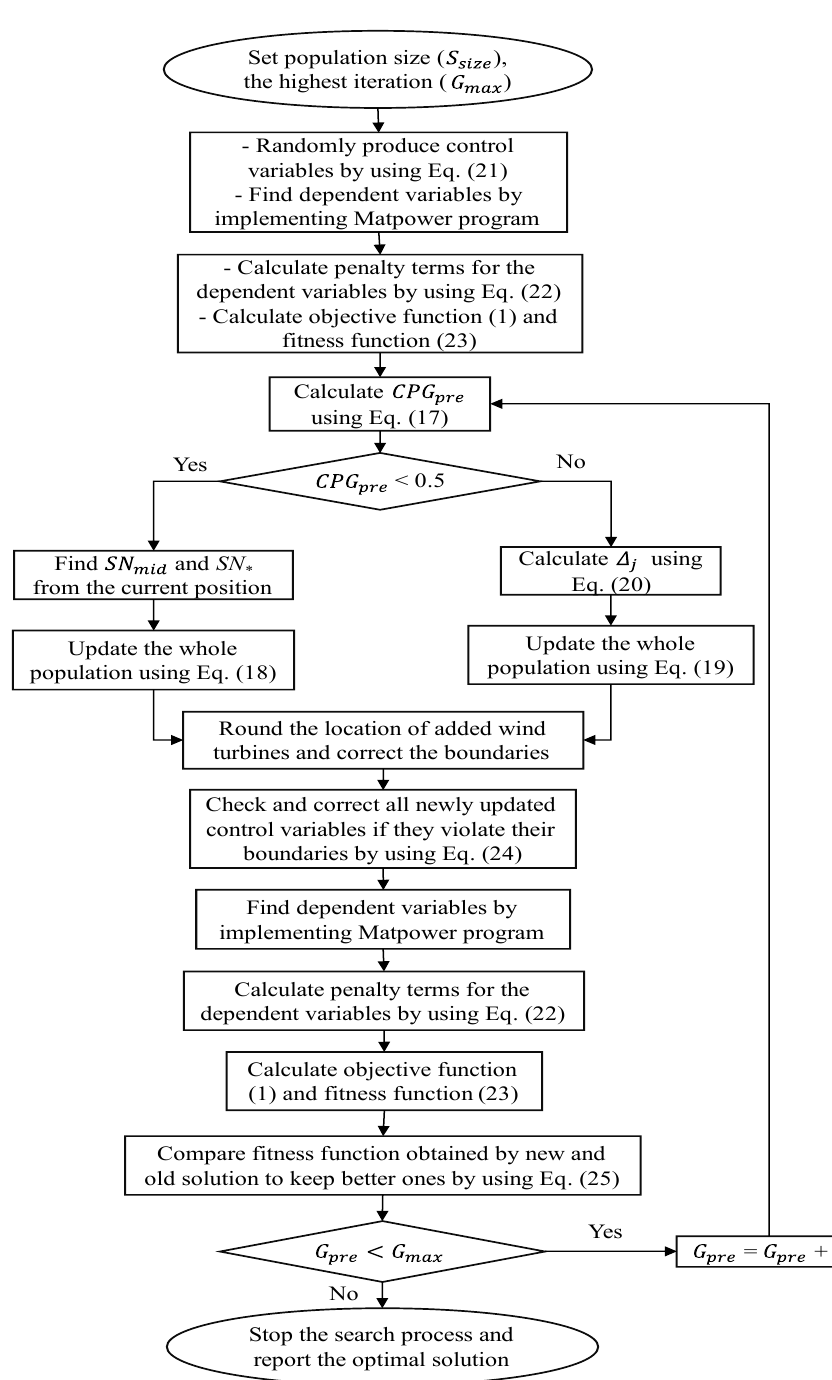
Figure 1. The solution search procedure of JSA for the considered problem.